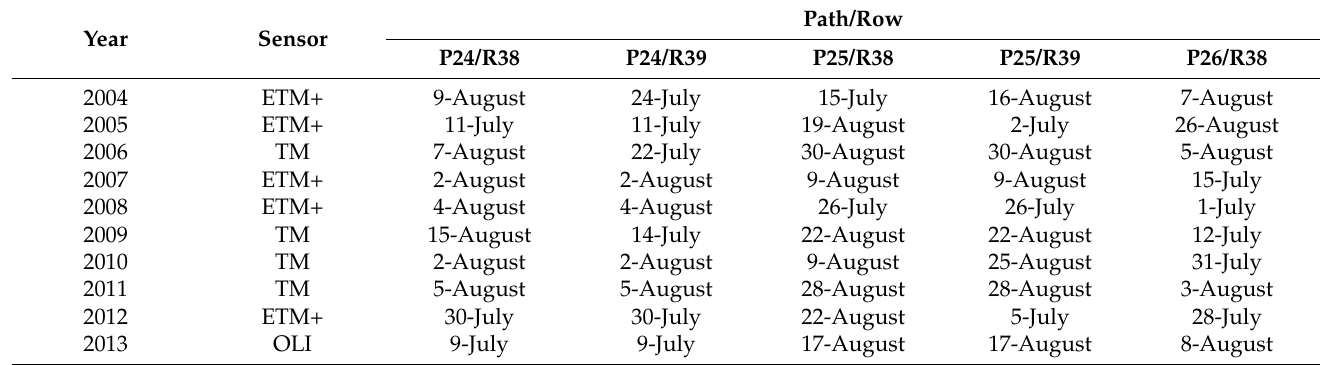
Table 2. Path/Row and dates of acquiring Landsat image data.